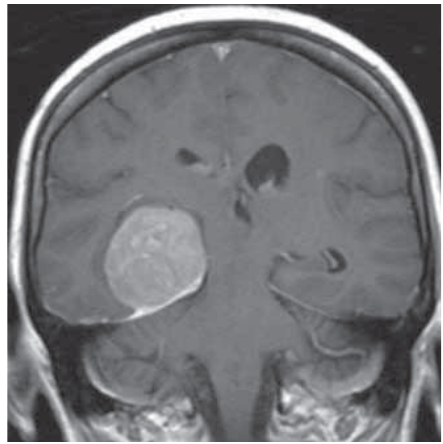
FIGURE 2. The coronal contrast-enhanced T1-weighted im- age reveals the left tentorial meningioma with the dural tail sign along left